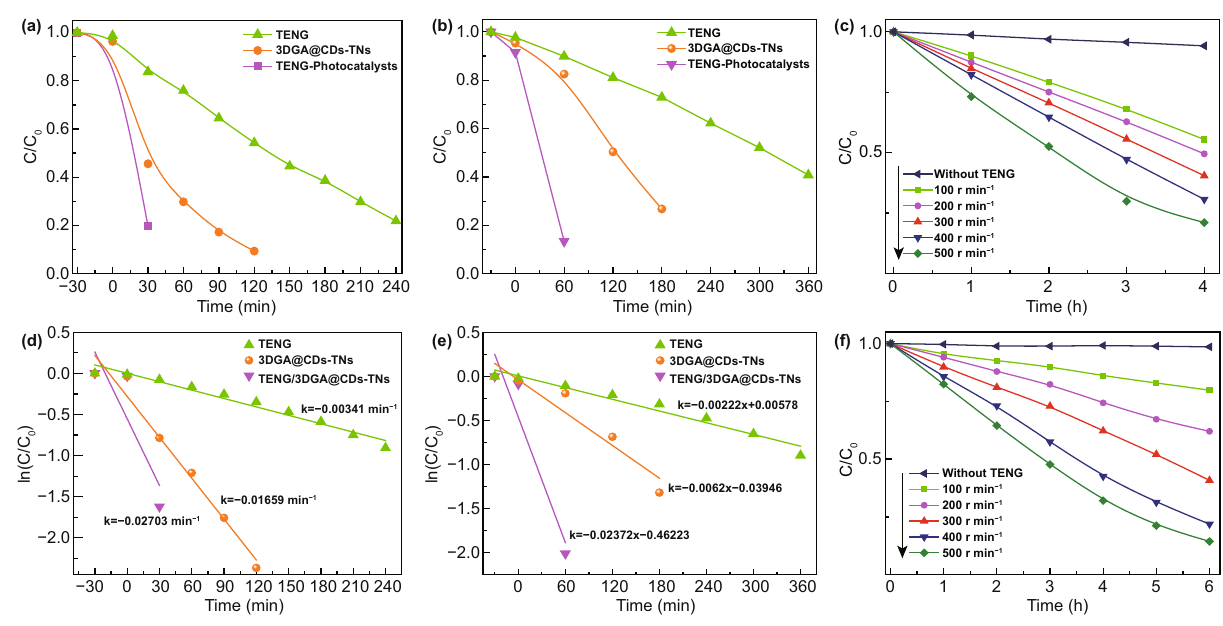
Fig. 5 Degradation and degradation kinetics curves of BG ( a , b ) and DB ( c , d ) for 3DGA@CDs-TNs photocatalyst, TENG, and TENG/3DGA@CDs-TNs. Degradation of e BG, f DB by TENG with different rotation rates